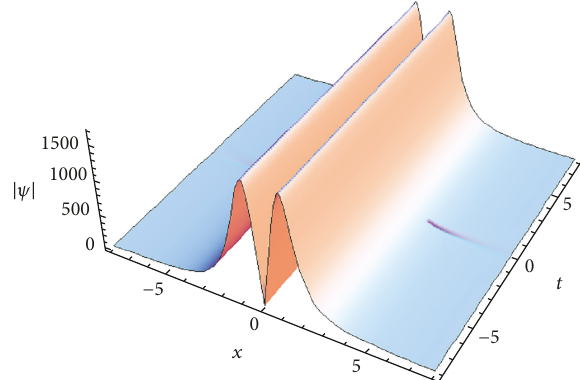
Figure 4: Spatial structure of the module of solution (20) with 𝑞 0 = 10000 .